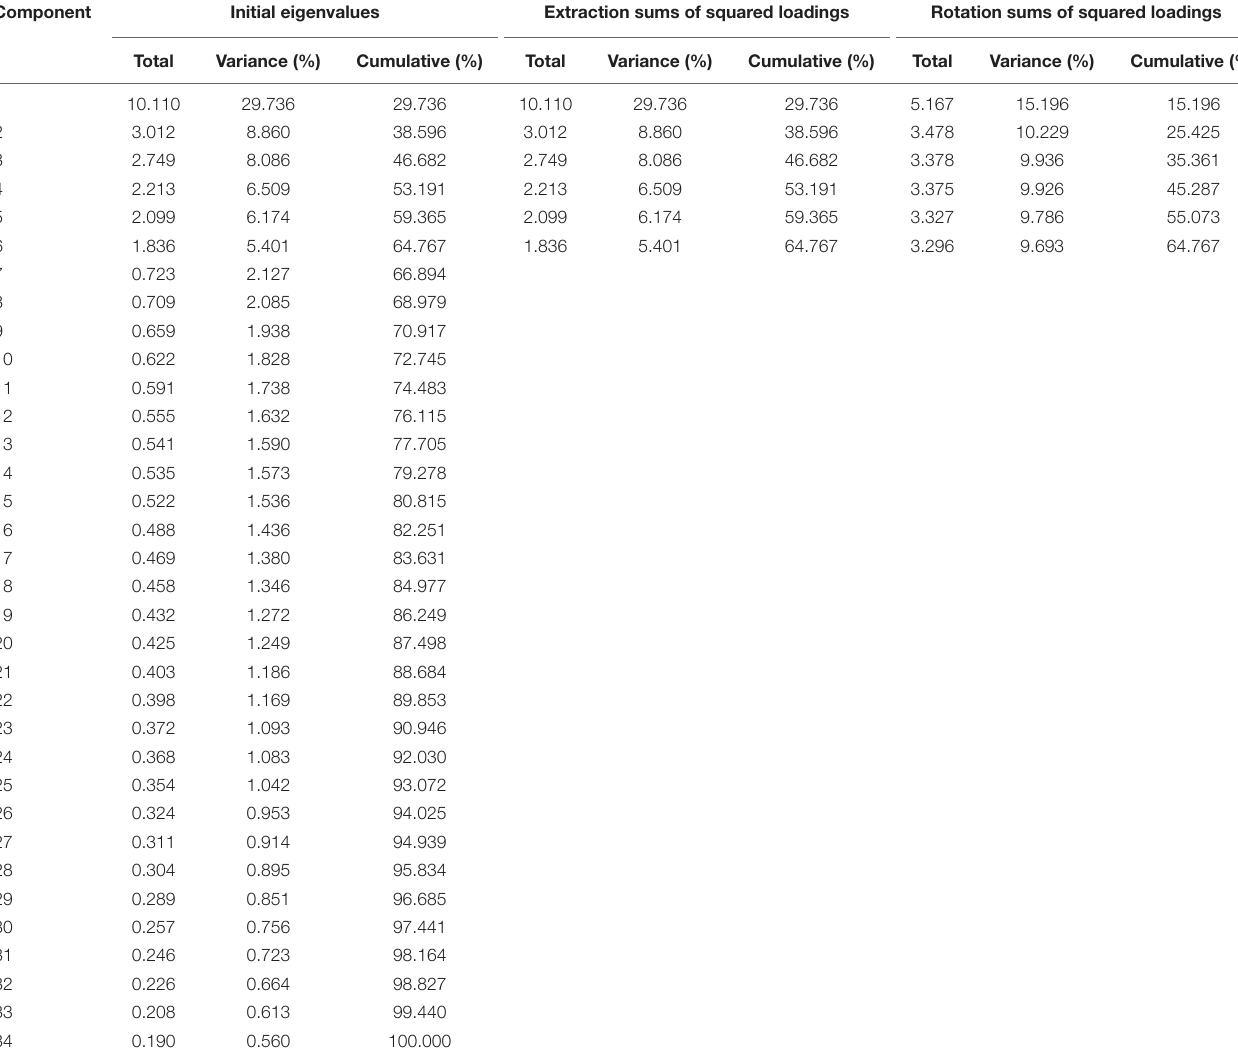
TABLE 5 | Total variance